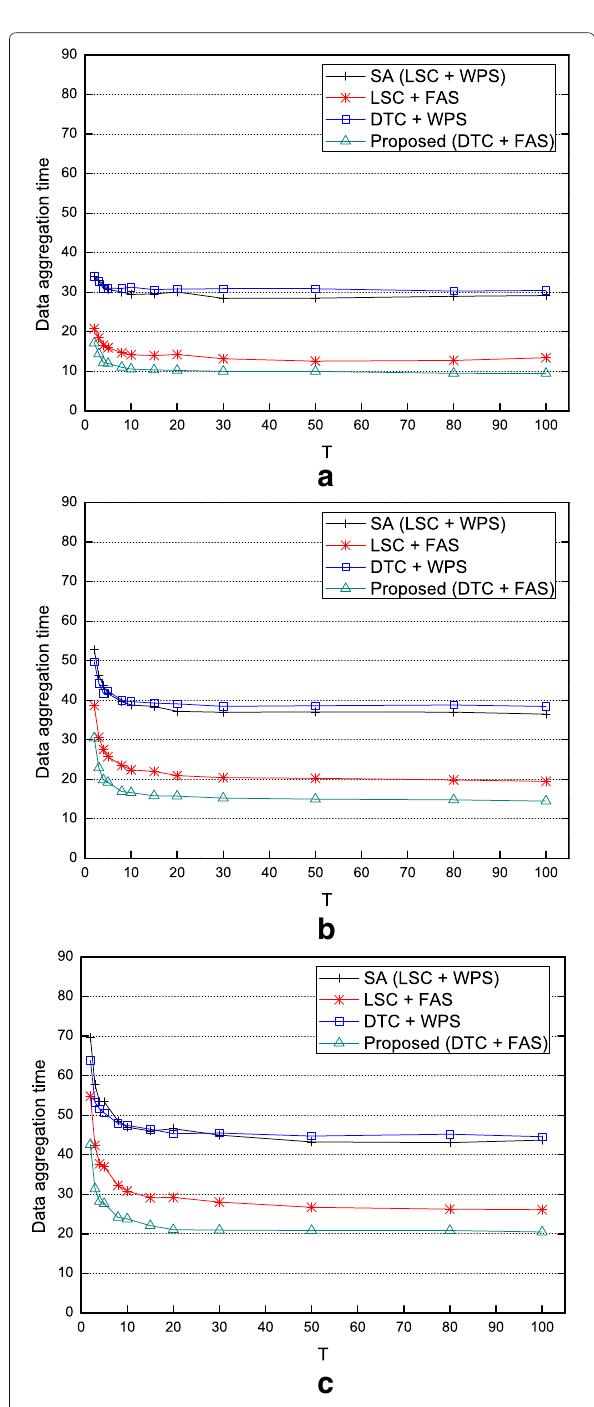
Fig. 6 Data aggregation time with different duty cycles. a Number of nodes = 200. b Number of nodes = 600. c Number of nodes = 1000